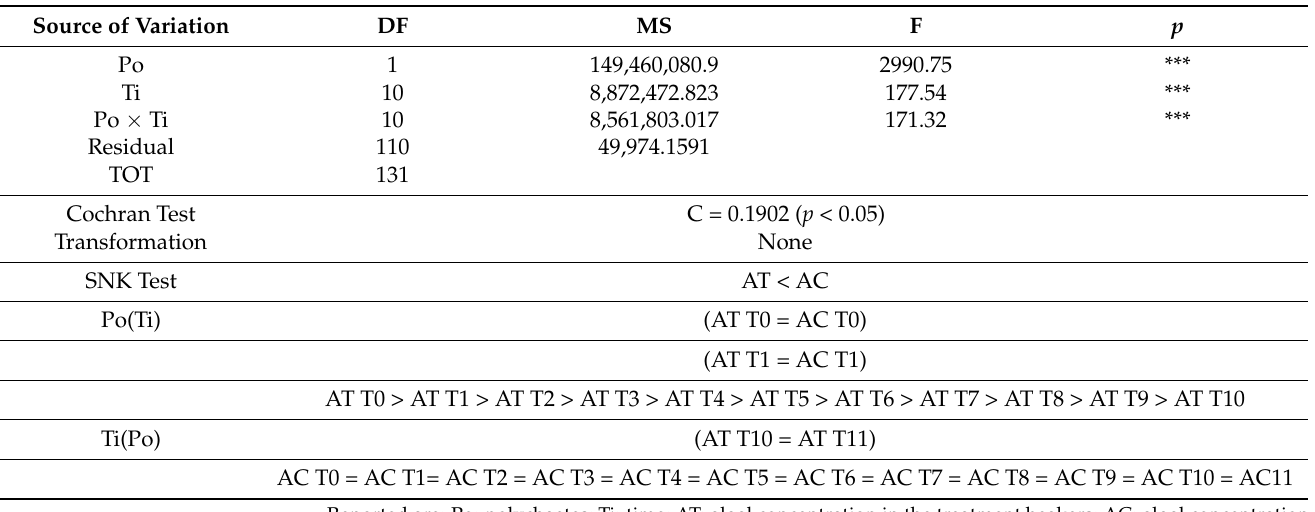
Table 2. Summaries of ANOVA testing for differences in average Amphidinium carterae abun- dances measured at the different sampling times in the control and treatment beakers with Branchiomma luctuosum